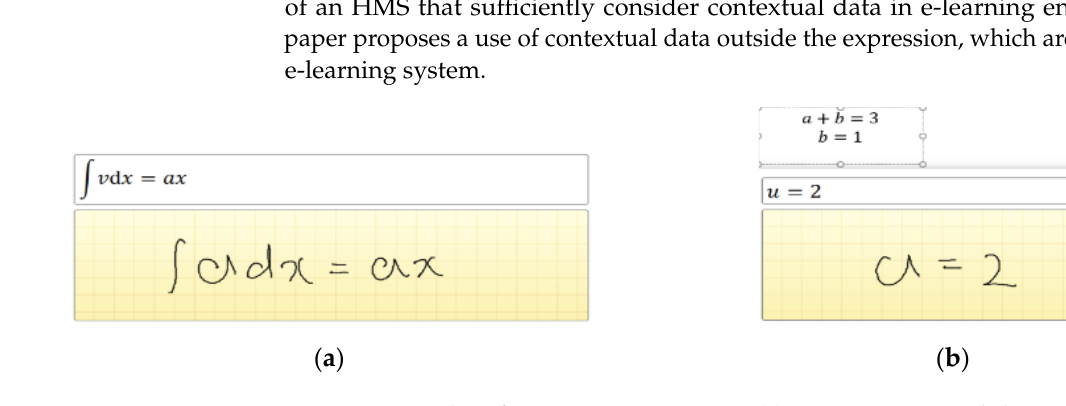
Figure 1. Samples of HMS misrecognitions. ( a ) Missing contextual data inside the expression. ( b ) Missing contextual data outside the expression.